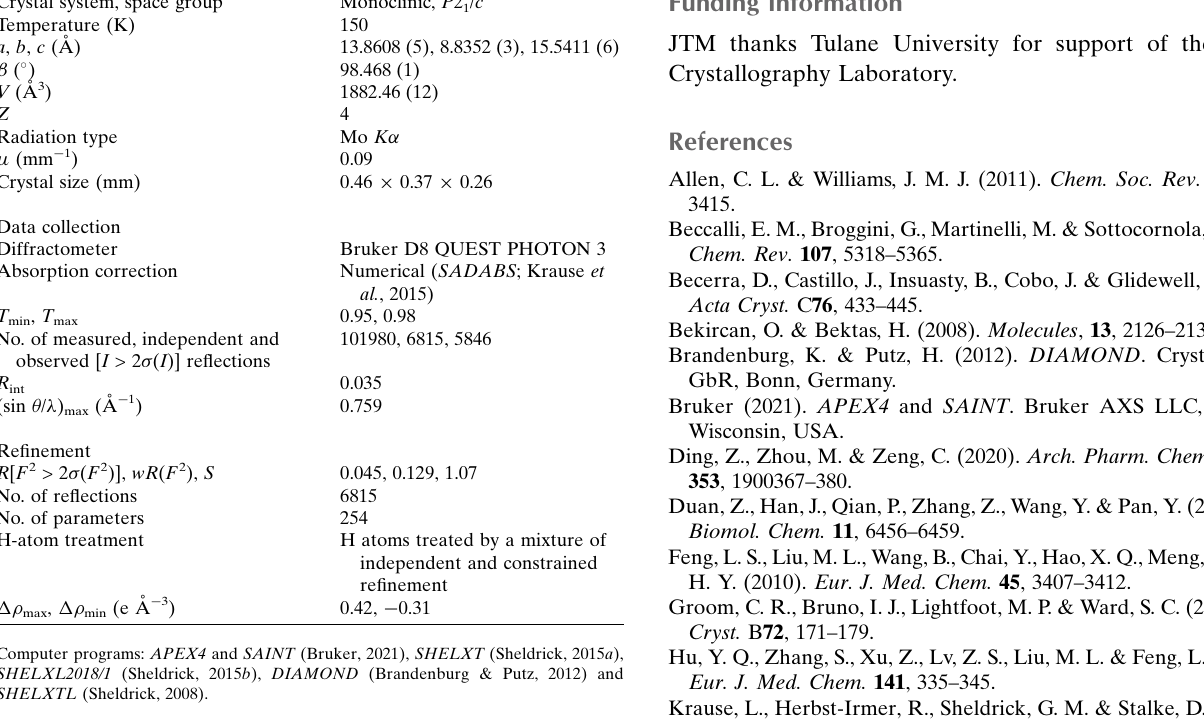
Table 2 Experimental details. Crystal data Chemical